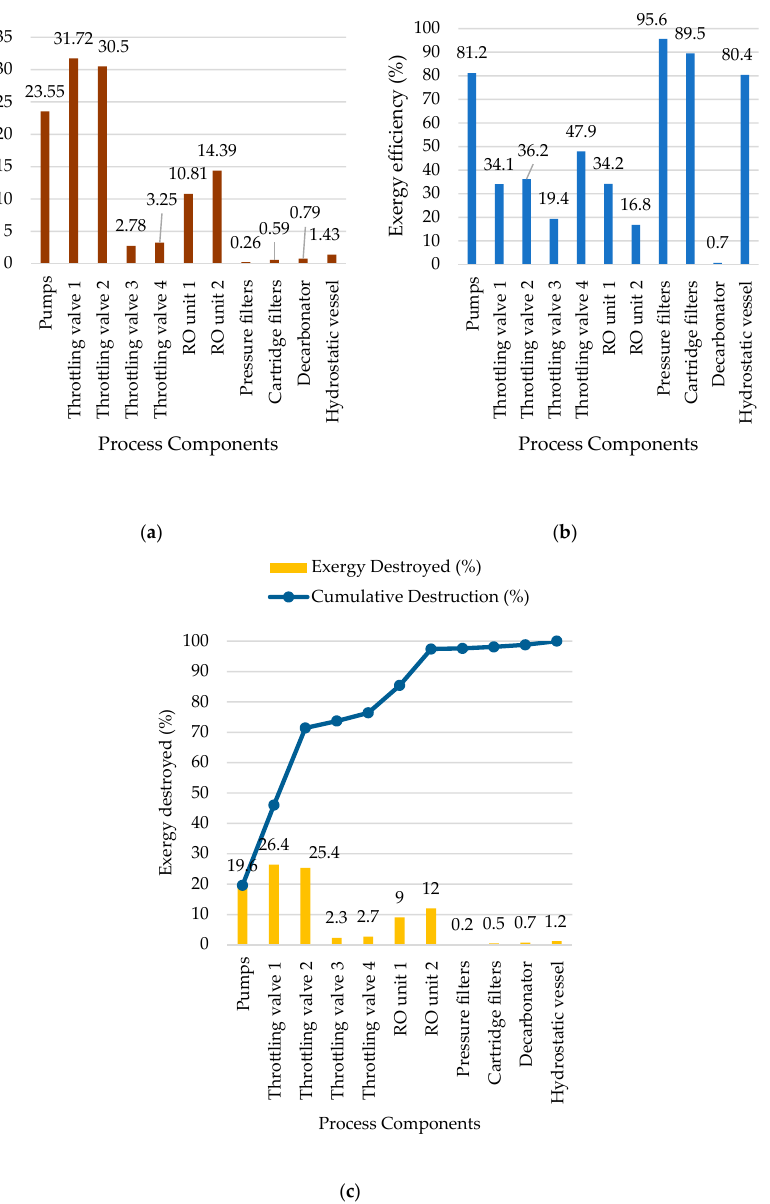
Figure 7. Exergy balance of a reverse osmosis unit receiving brackish water: ( a ) exergy destroyed (kW); ( b ) exergy efficiency (%), and ( c ) exergy destroyed (%).